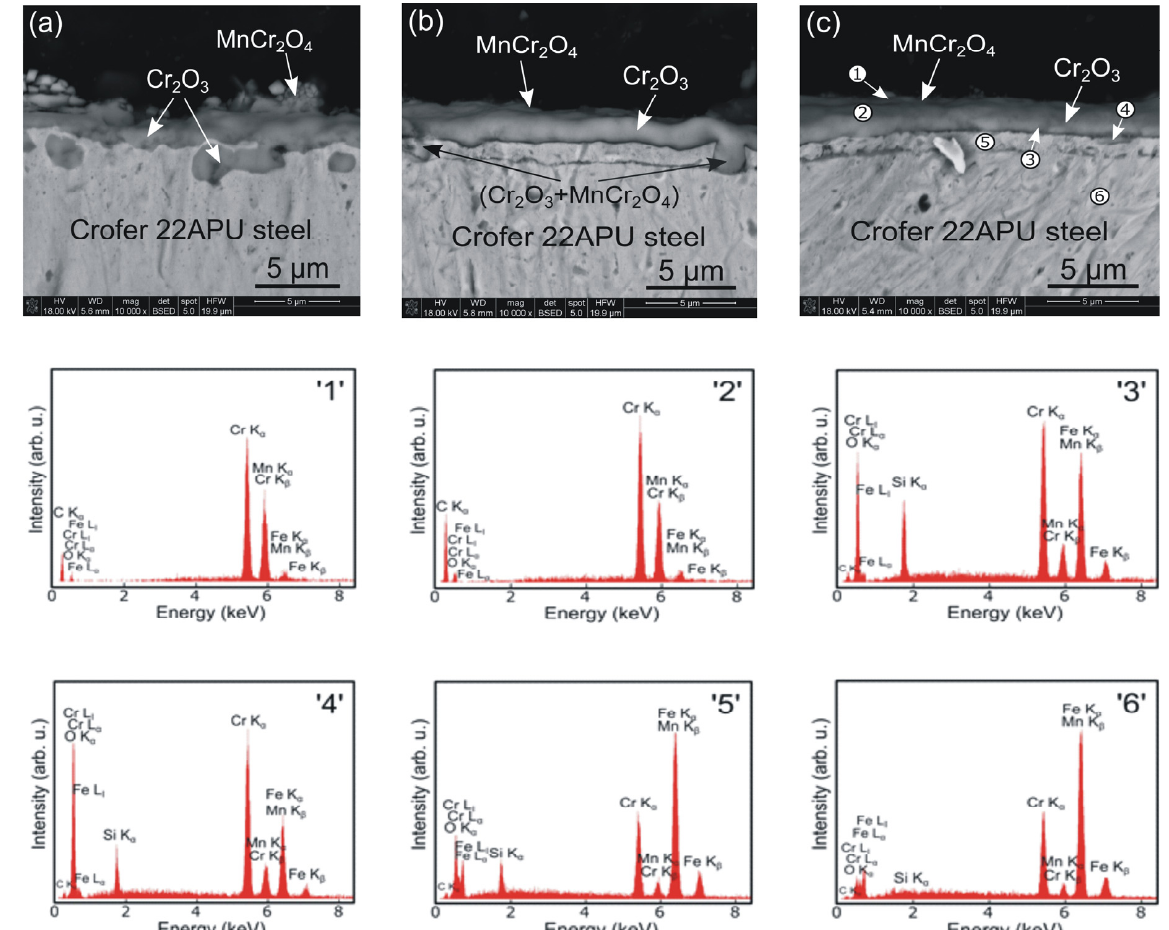
Figure 9. SEM cross-section microphotographs of ( a ) unmodified Crofer 22APU steel, ( b ) Crofer 22APU with the deposited SiC x N y :H layer, and ( c ) Crofer 22APU with the layer deposited after N + ion modification (N + /SiC x N y :H) obtained after oxidation at 1073 K in the air for 500 h as well as EDS point analyses spectra obtained from locations ‘1’–‘6’ indicated in Figure